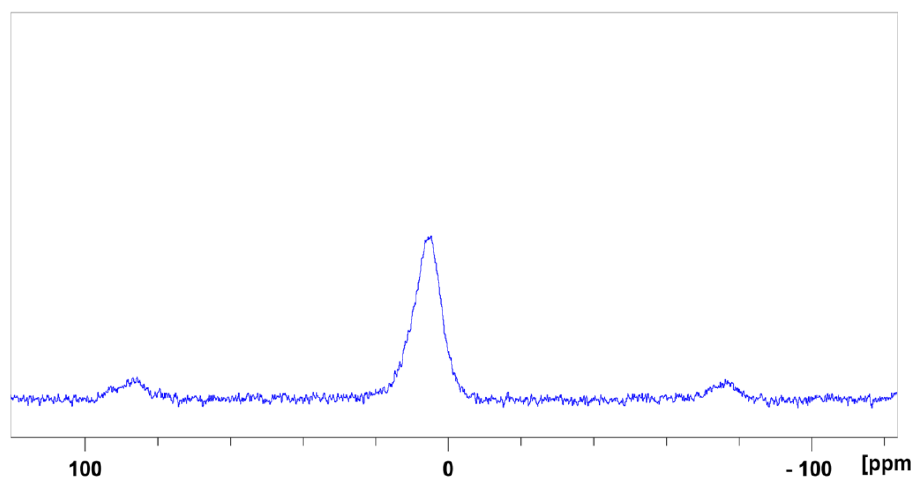
Figure 5. ³¹P NMR spectrum of regenerated cellulose dissolved in [DIMIM][(MeO)(H)PO 2 ] (mass fraction of cotton in[DIMIM][(MeO)(H)PO 2 ]; 5 wt%).